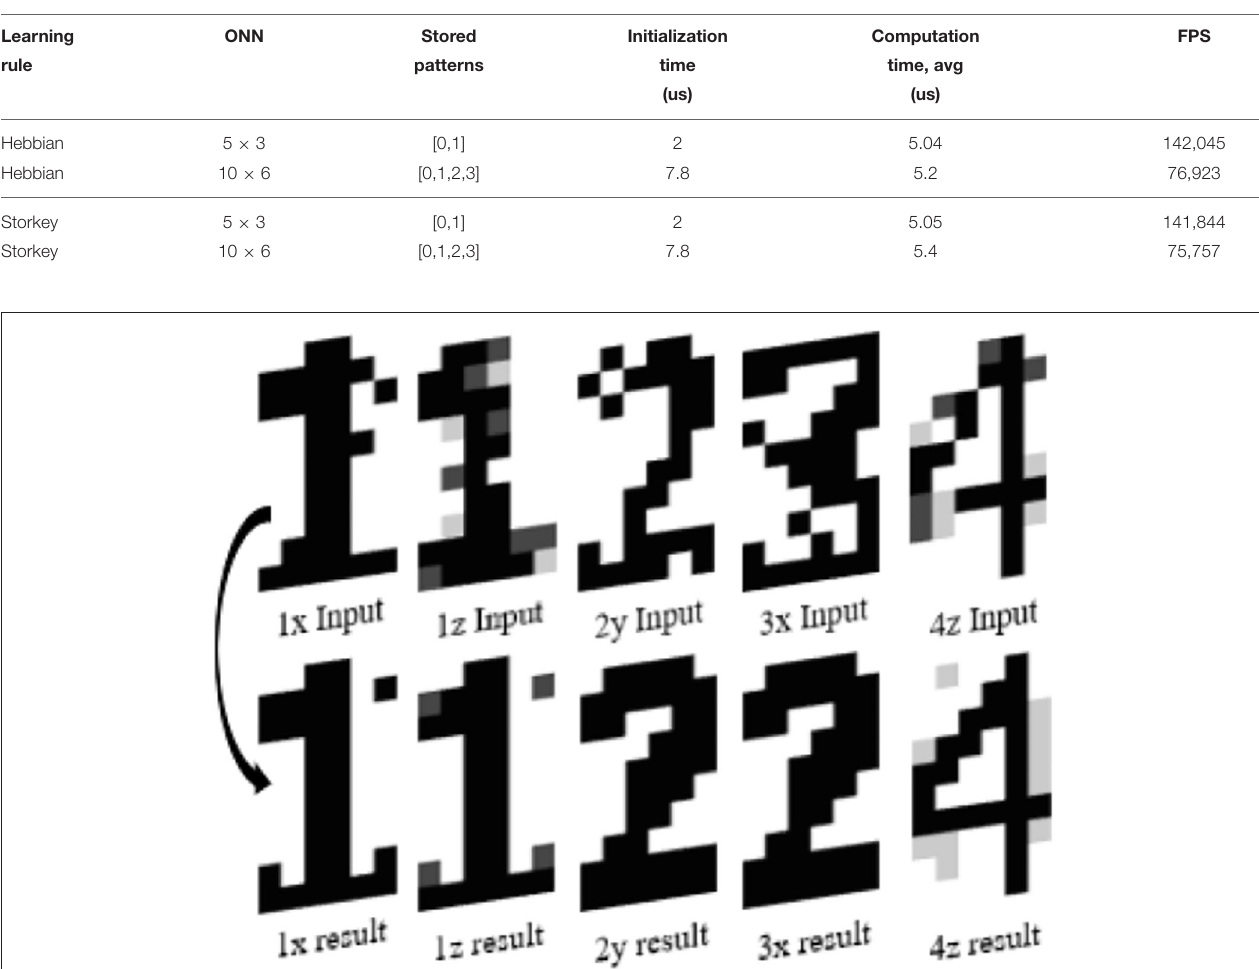
TABLE 5 | ONN timing performances for various sizes (number of neurons) and learning rules.